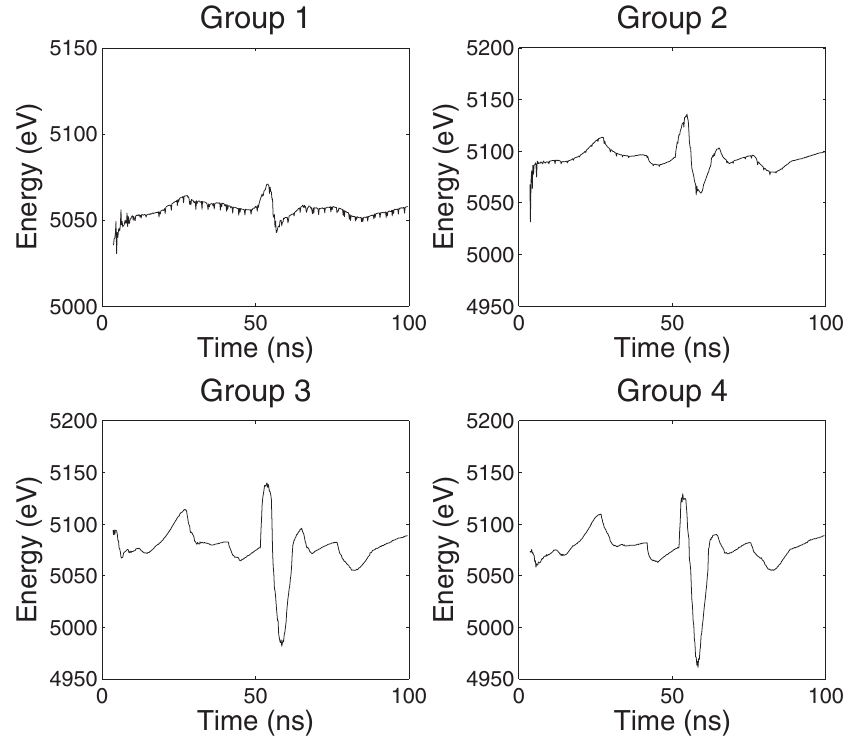
FIG. 3. Mean energy waveforms derived from energy analyzer signals for different groups.